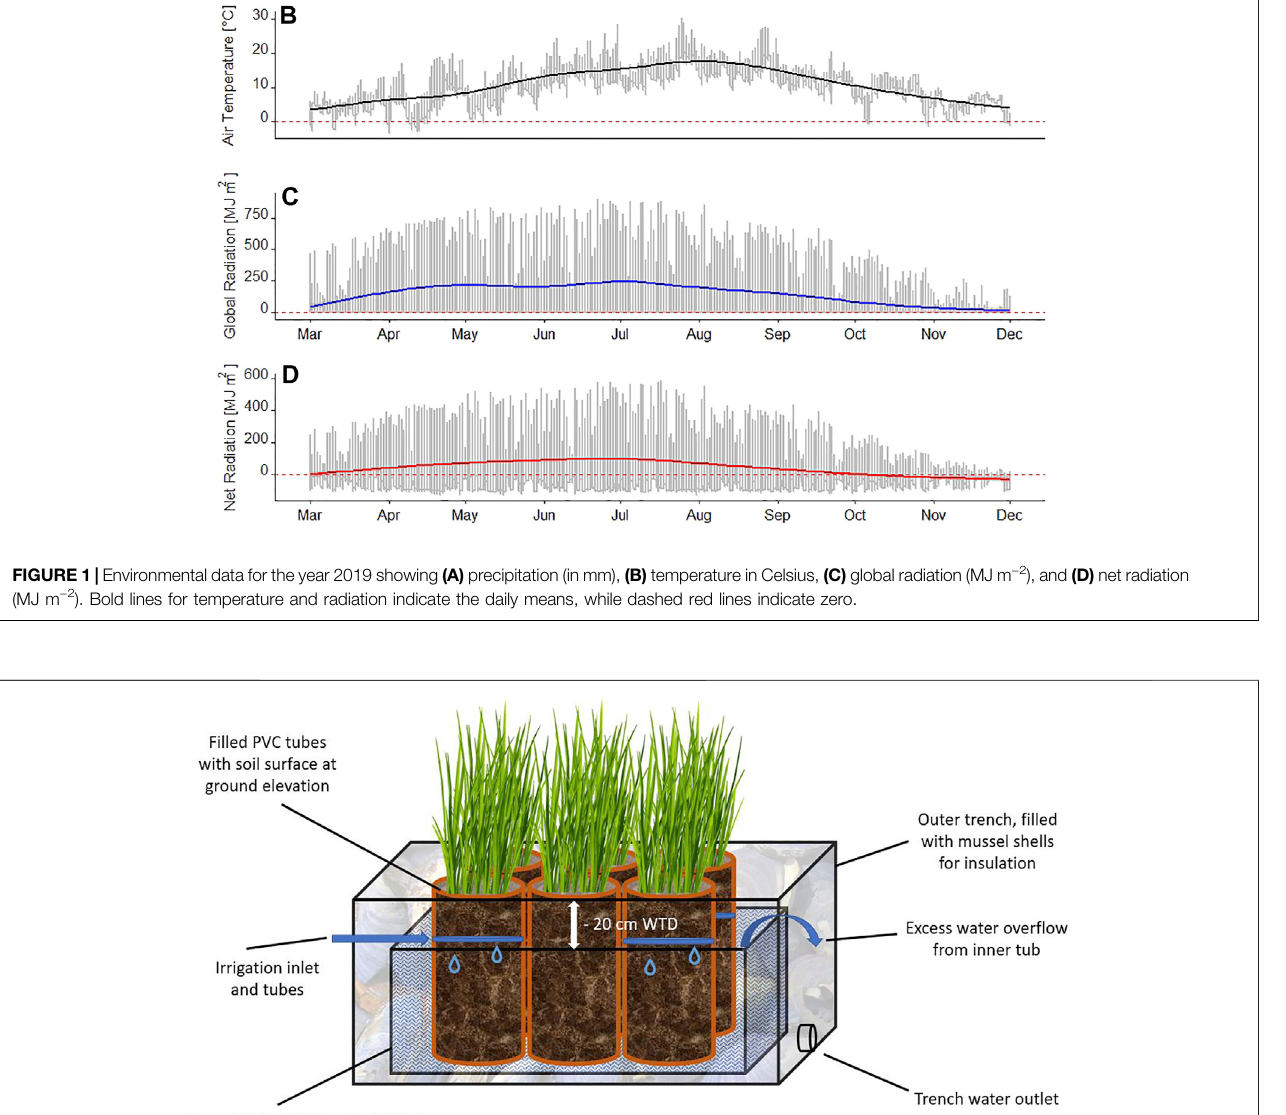
Frontiers in Environmental Science |